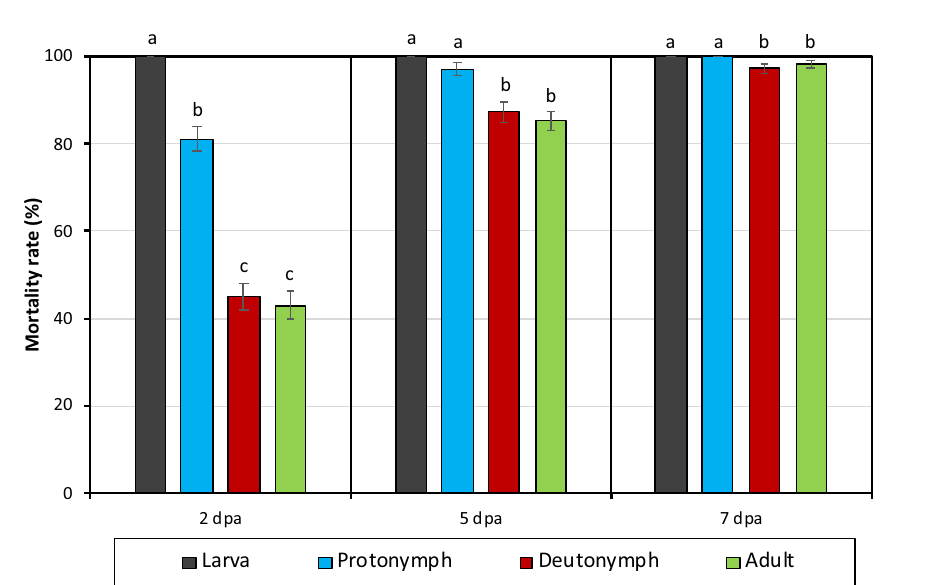
Figure 2. The mortality of induced or non-induced mutant strains of X. szentirmaii on Tetranychus urticae females.